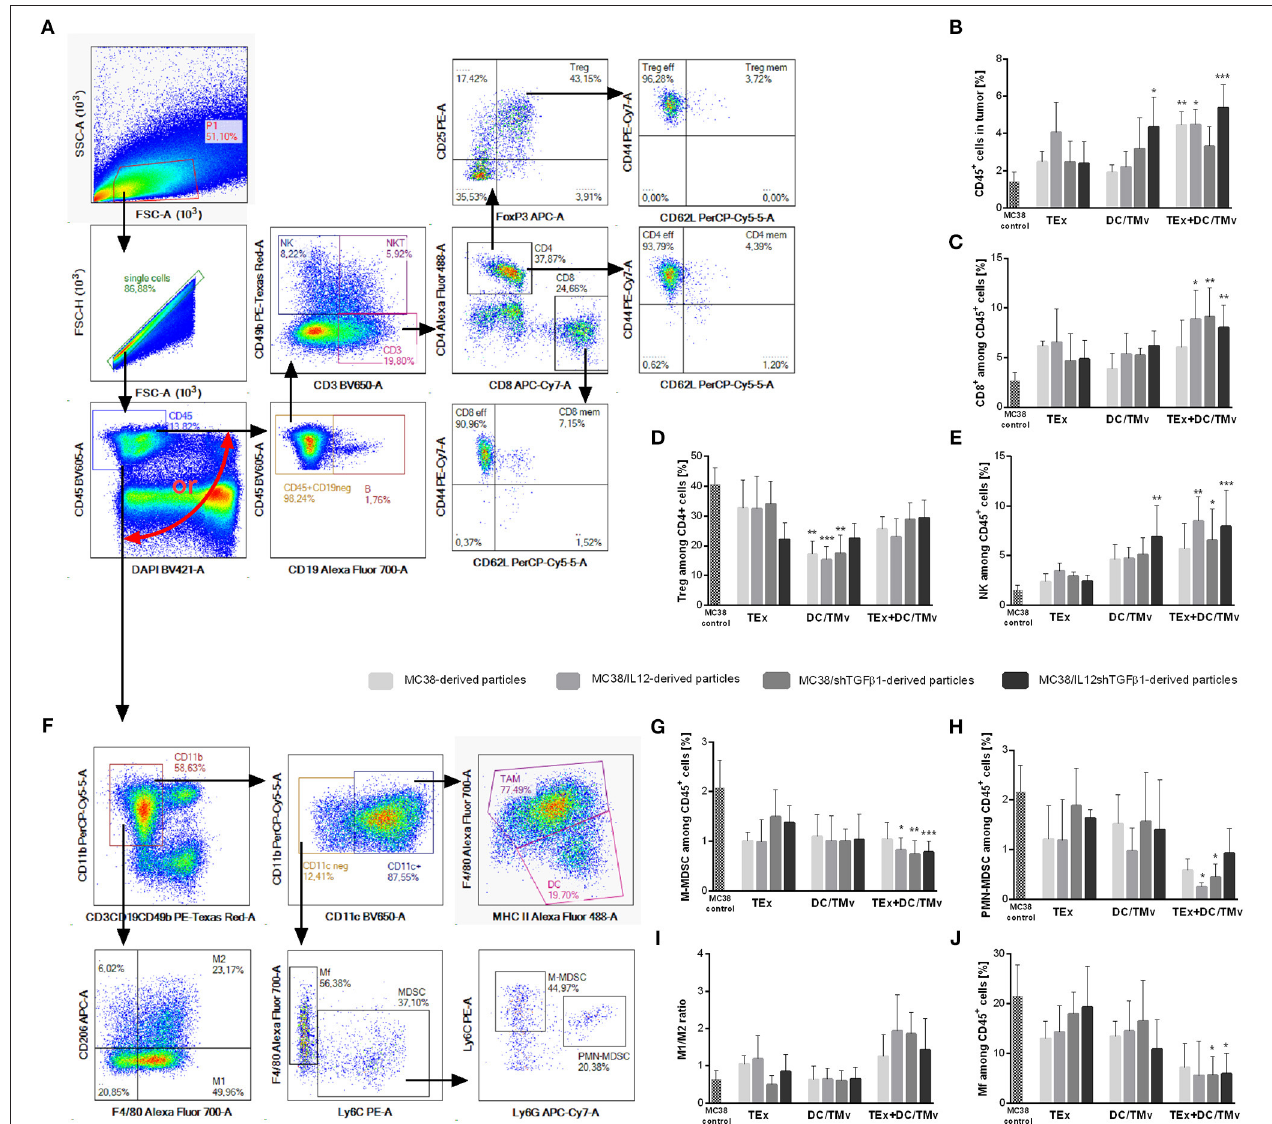
FIGURE 5 | The influence of immunotherapy on the immune landscape in MC38 tumor nodules. (A,F) Schemes of multiparameter flow cytometric analyses showing the way of distinguishing lymphoid (A) or myeloid (F) cell subpopulations. (B) The percentage of leukocytes in tumor nodules. (C–E,G,H,J) Percentages of effector or suppressor cell subpopulations which underwent changes during therapy. (I) The M1/M2 ratio showing changes in polarization of tumor-infiltrating macrophages occurring during therapy. To calculate the mean ± SD, 6–8 mice per group were analyzed. The differences between the groups were estimated using the nonparametric Kruskal-Wallis test followed by Dunn’s multiple comparison test (* p < 0.05, ** p < 0.01, *** p < 0.001 in reference to MC38